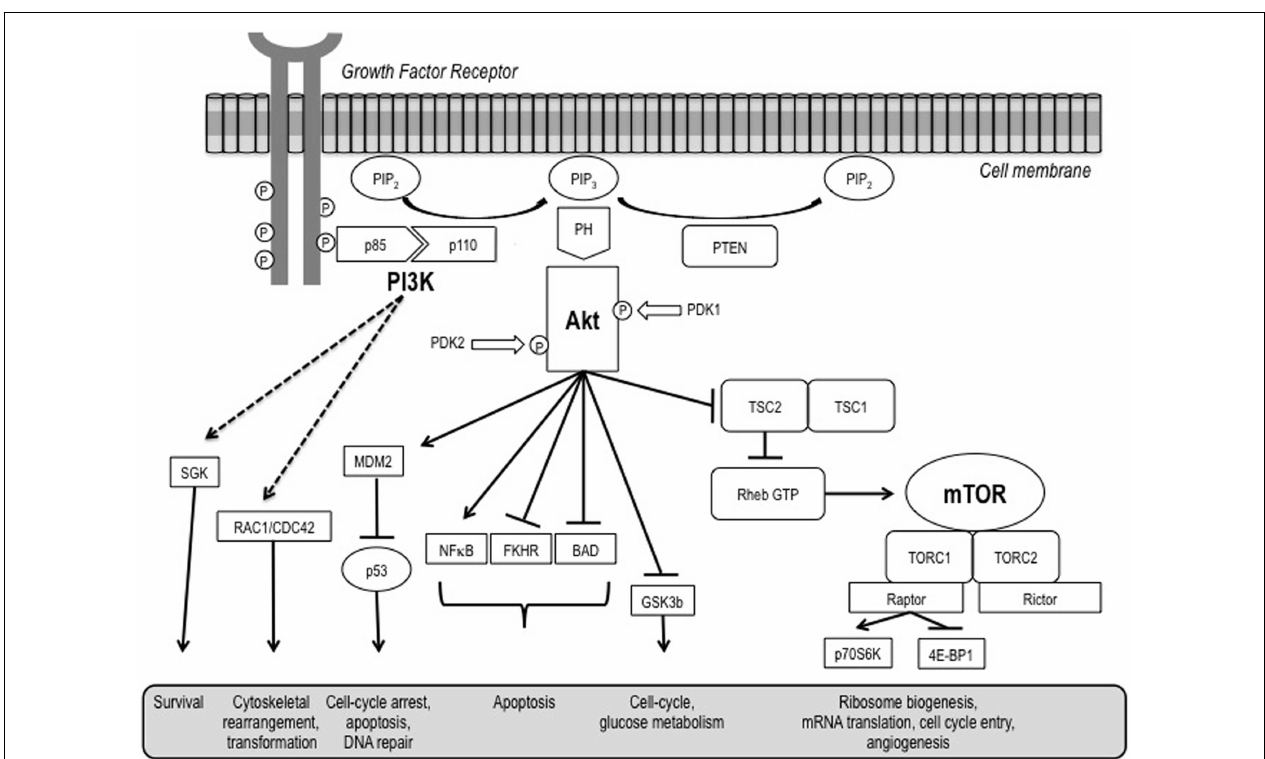
FIGURE 1 |A schematic representation of the PI3K/Akt/mTOR pathway